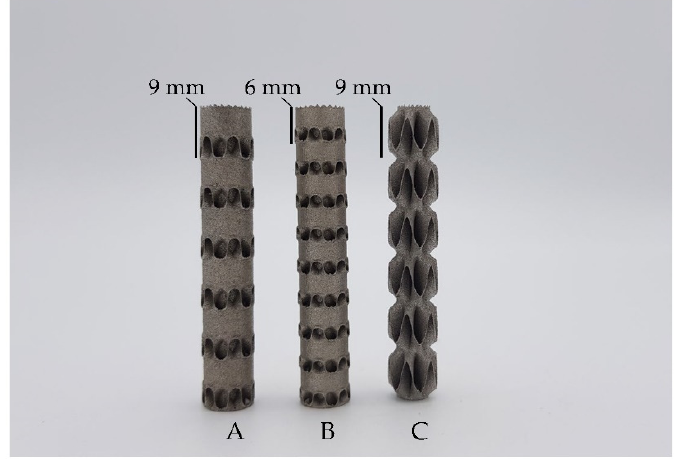
Figure 3. Fluid Guiding Element types used in this study.